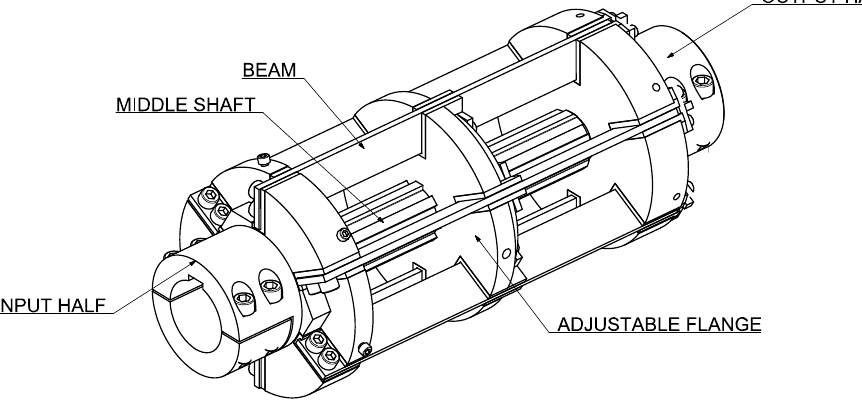
Fig. 1. The main parts of the